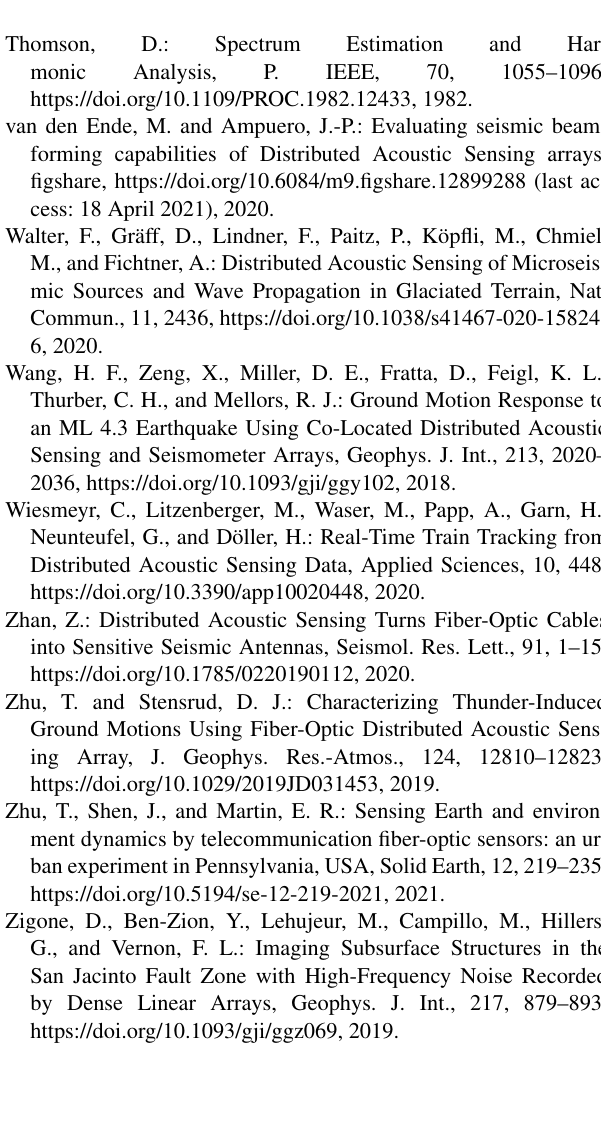
figshare, https://doi.org/10.6084/m9.figshare.12899288 (last